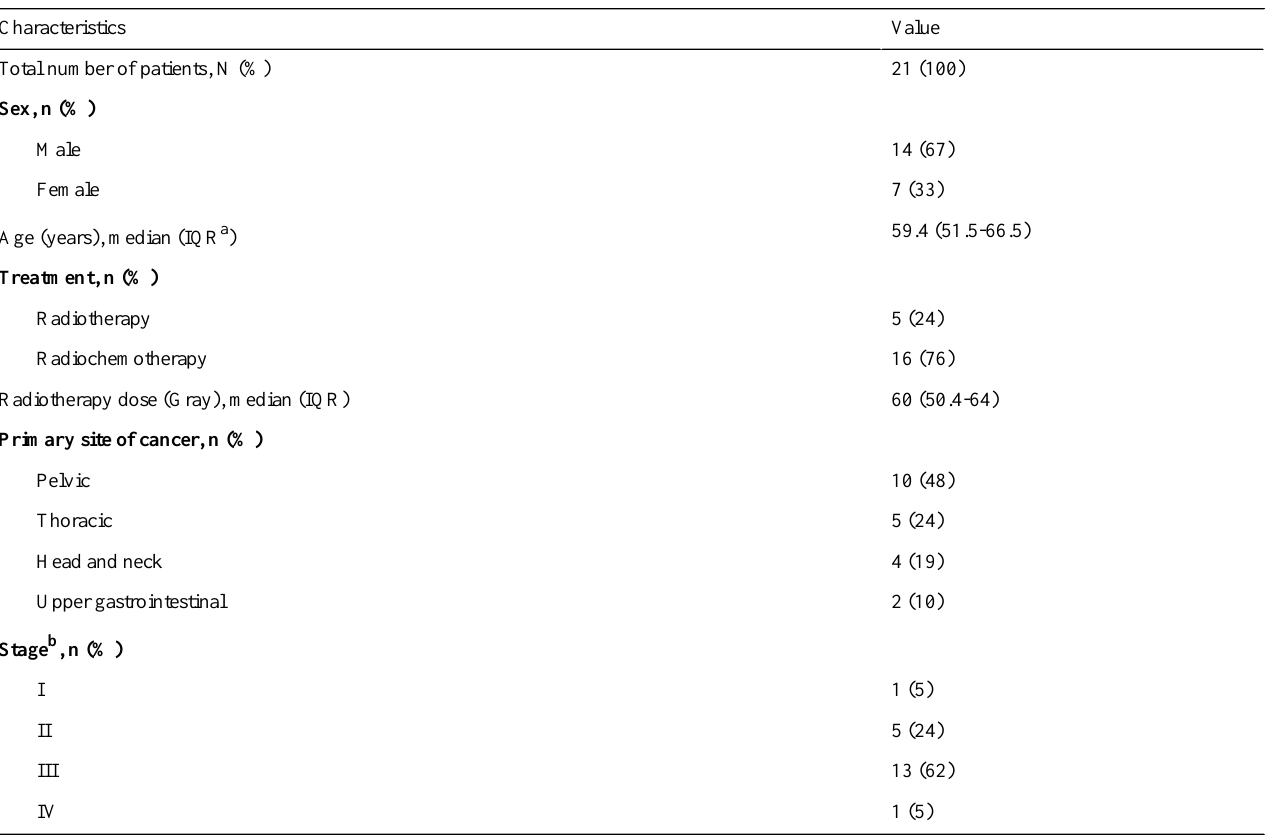
Table 1. Patient and treatment characteristics.